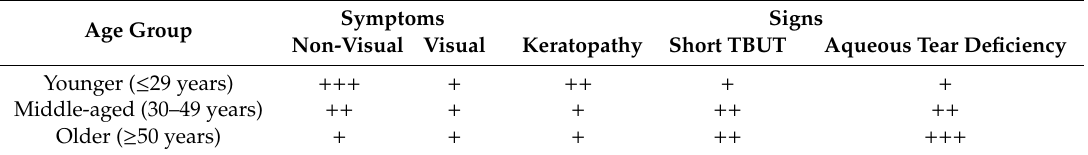
Table 4. Summary of the association between age and dry eye-related signs and